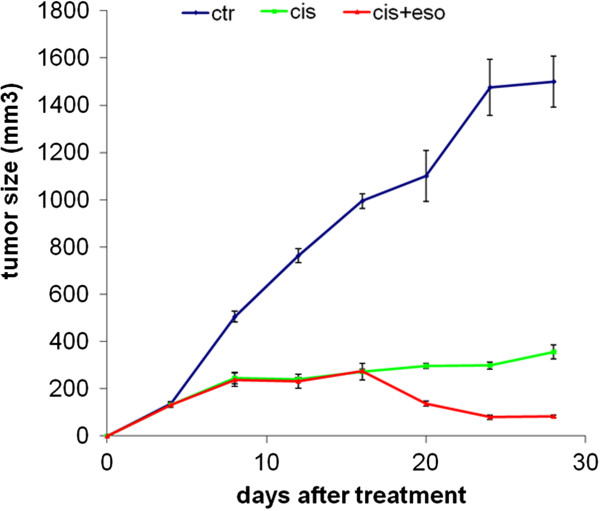
In vivo effects of ESOM on tumor growth in CB.17 SCID/SCID mice. Mice were engrafted with Saos-2 cells via s.c. injection in the right flank. At the time of tumor appearance (approximately 7–10 days after injection), mice were left untreated or were pre-treated with 25 mg/kg of ESOM 24 hrs before the i.p. injection of CDP or treated with CDP alone. Tumor size was measured three times per week, and volume was calculated as described in the “Methods” section. The histograms represent mean +/− 95% confidence intervals of tumor weight.